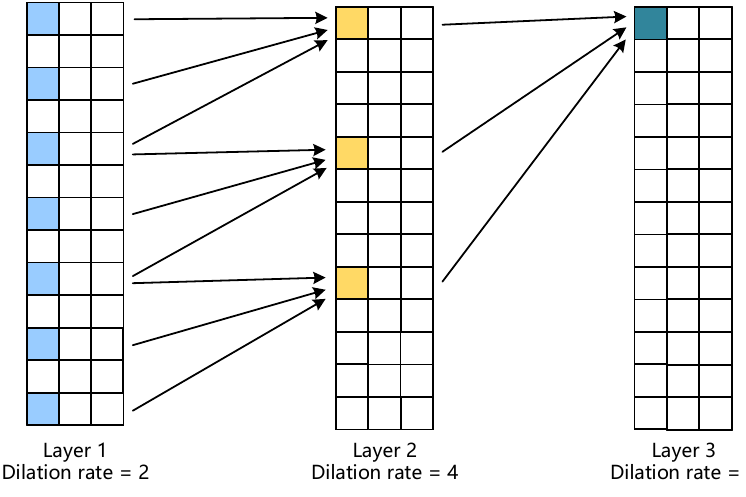
Figure 8. Data dependency of DGCNN.